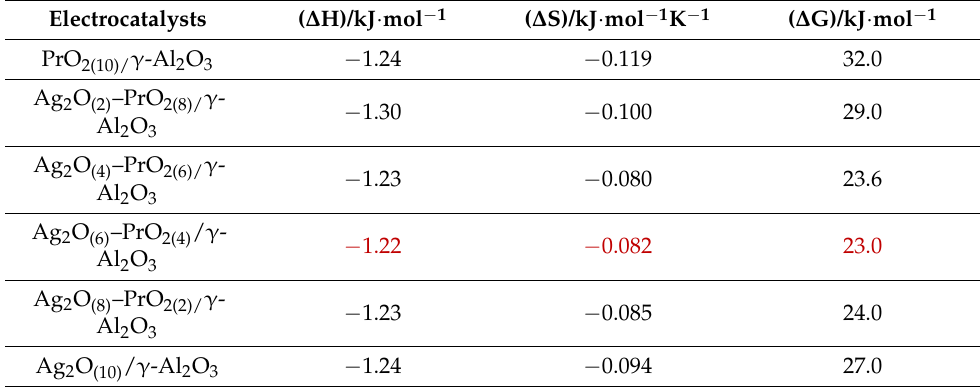
Table 6. Thermodynamic parameters calculated from the Marcus equation.